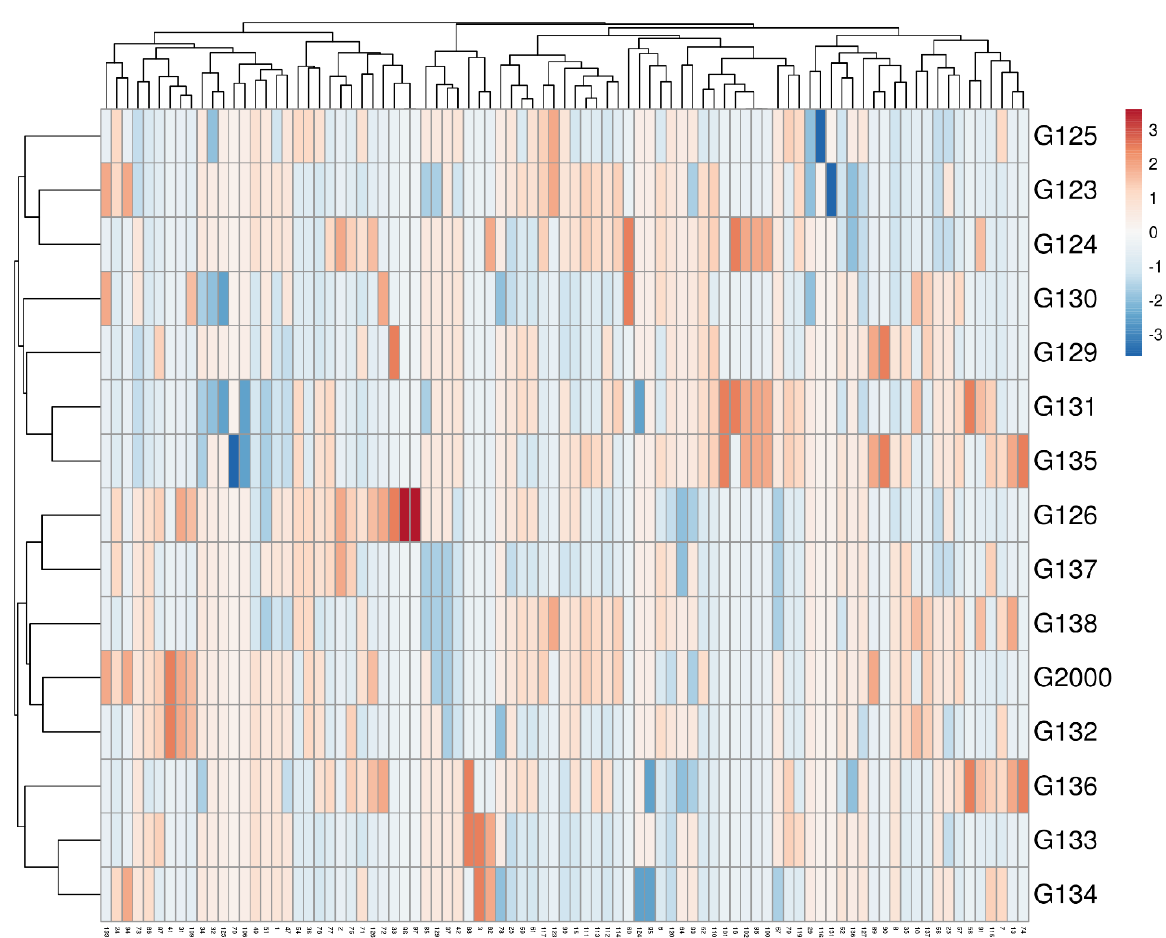
Figure 6. Multivariate heatmap illustrating the genetic diversity of 15 Egyptian six-rowed barley cultivars, based on the 15 ISSR primers for using the module of a heatmap of ClustVis—an online tool for clustering and visualizing of multivariate data [ 41 ] .